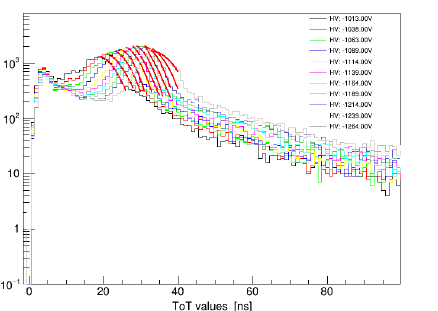
Figure 1. Example of ToT histograms and the cor- responding Gaussian fit for PMT#5 of DOM#3 of string#1 and for several high voltage o ff set values. The tuning is done with 25 V steps of HV and ToT is calculated by means of a Gaussian fit function to the ToT distribution during 1 min of data taking for each step. The average ToT value, estimated on a subset of PMTs with properly calibrated gain (3 10 6 ), corresponds to 26.4 ×